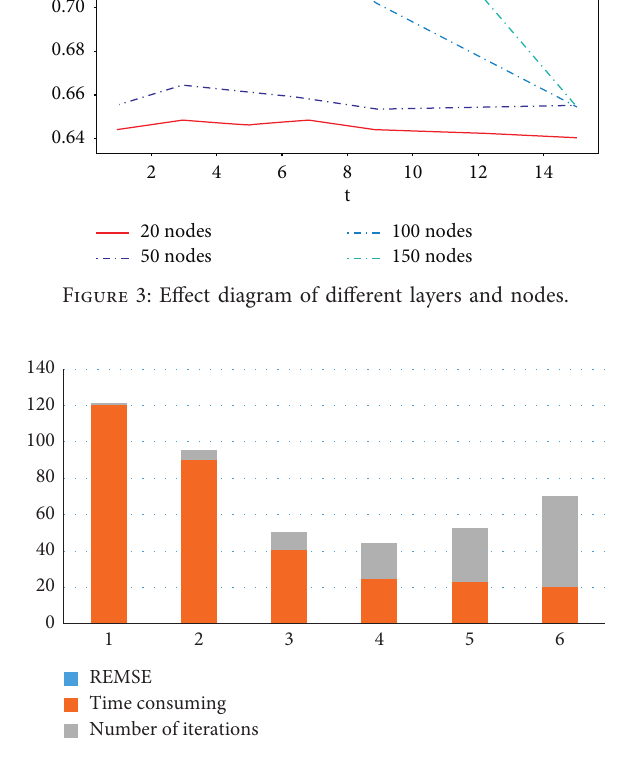
Figure 4: Model effect diagram under different